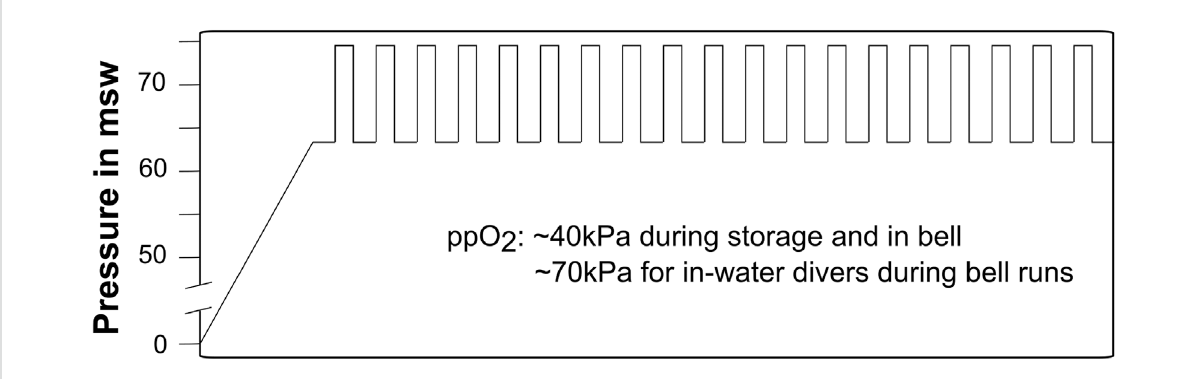
FIGURE 1 Heliox saturation dive pro fi le. Vertical bars indicate bell runs. The storage depth was kept at 63 msw, and the maximum working depth was 74 msw. Partial pressure of oxygen was kept close to 40 kPa during storage, and raised during bell runs to 60 – 80 kPa for the in-water divers and 40 – 50 kPa for the